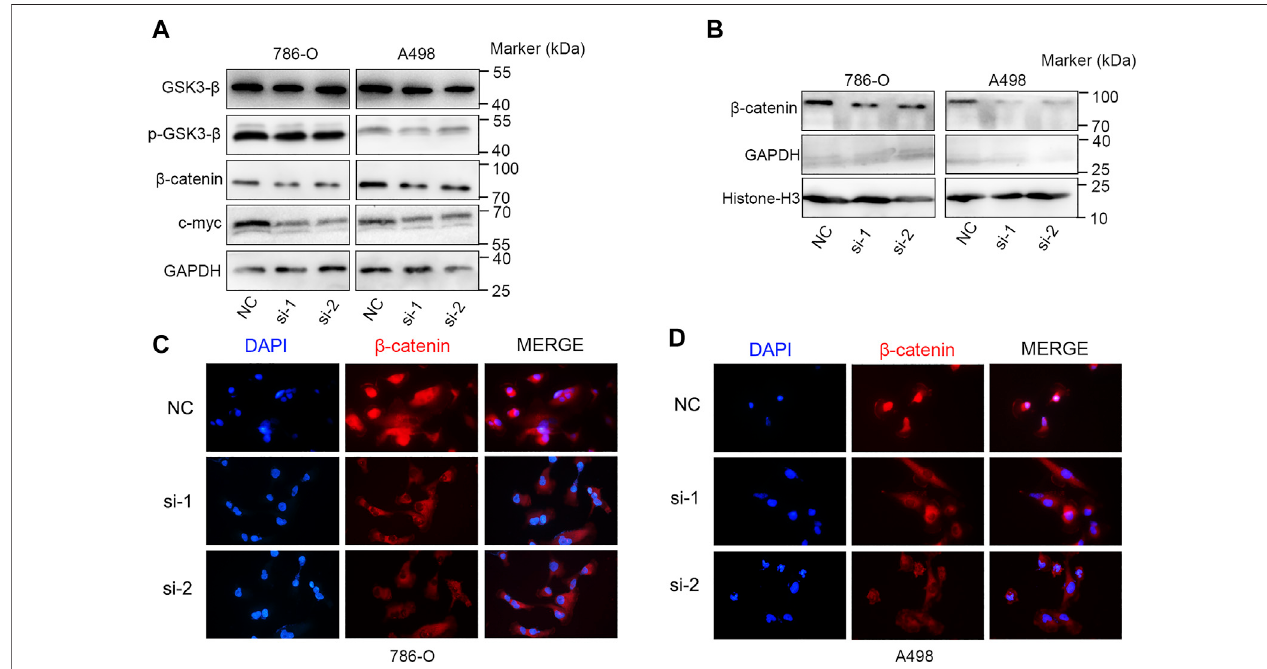
FIGURE 10 | KIF23 knockdown inhibits the Wnt/ β -catenin signaling pathway. (A) KIF23 knockdown reduced the levels of p-GSK3- β , β -catenin and c-Myc. (B) KIF23 knockdown reduced β -catenin levels in the nucleus. (C,D) Immuno fl uorescence staining of β -catenin in 786-O and A498